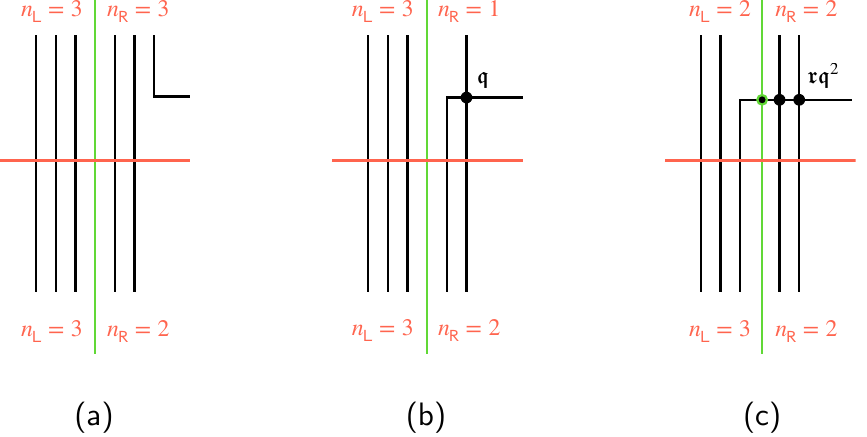
Figure 5 . (a) The Hilbert space of JT gravity with a particle (green) in the wormhole. The matter particle divides a geodesic from the left to right boundary into two pieces, with lengths ‘ L and ‘ R . The disk partition function with two operator insertions is obtained by imposing ‘ L = ‘ R = 0 boundary conditions in the Euclidean past and future. (b) The Hilbert space of double scaled SYK with an operator insertion M s represented by a green chord. The Hilbert space is spanned by states labeled by two integers n L , n R that are the left and right chord numbers.